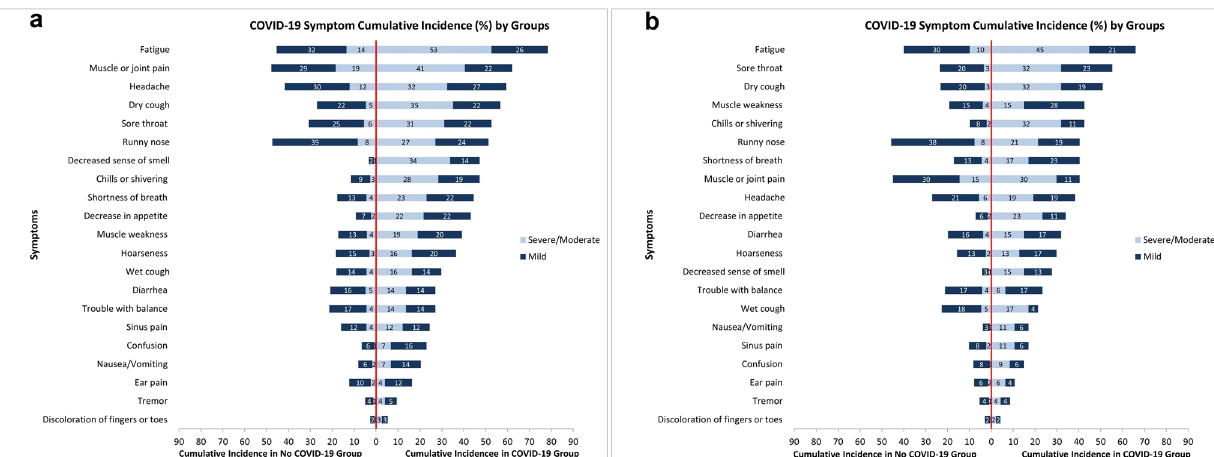
Fig. 2 Cumulative incidence of mild and moderate/severe symptoms by sex. a Cumulative incidence percent of mild (dark blue) and moderate/severe (light blue) symptoms since March 2020 reported by non-COVID-19 and COVID-19 female participants. b Cumulative incidence percent of mild (dark blue) and moderate/severe (light blue) symptoms since March 2020 reported by non-COVID-19 and COVID-19 male participants. Data to reproduce this fi gure are included in Supplementary Data 2.